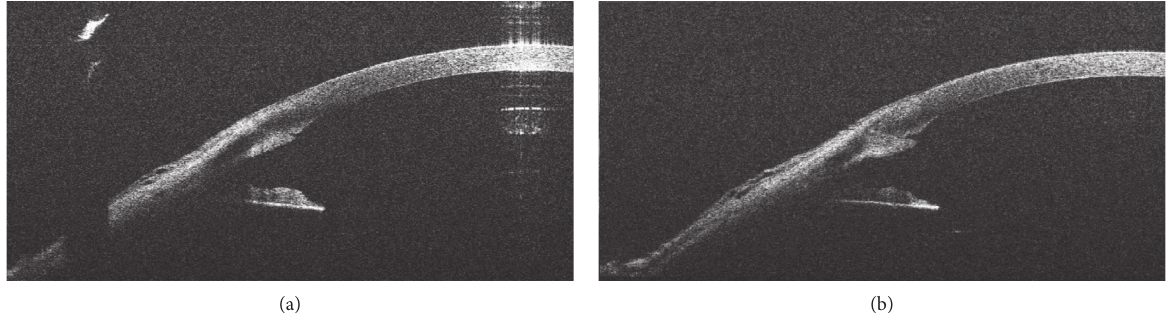
Figure 6: Worsening of corneal incision morphology after its hydration. Posterior lip prominence presented before hydration (a) worsened after lateral stromal hydration